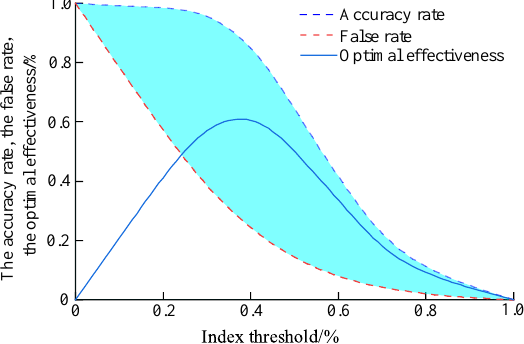
Figure 14. The relationship between critical value of index and early warning effectiveness. Taking the “strong pressure” as an example, Figure 15 illustrated four indexes (i.e., microseism frequency, microseism energy, daily advancement, and support resistance) together for further discussion. The threshold values of these four indicators are 0.49~0.61, 0.57~0.69, 0.65~0.68, and 0.85~0.97, respectively. Correspondingly, the optimal effectiveness of warnings are 0.89, 0.67, 0.50, and 0.67, respectively. Similar to other observations, the microseism frequency, microseism energy, and advancement rate are all positively correlated with the damage range, whereas the support resistance is negatively correlated with the damage range. The effectiveness of the microseism frequency indicated that the microseism events can reflects the activity of the lower key strata. The frequency exceeded the threshold value when the 8th, 9th, and 11th strong pressures occurred. However, the values of these indexes approximately reach the threshold value at the 9th and 11th. Considering the overestimated advancement rate, integrating the above indicators to comprehensively identify the mining-induced stress strength is requested.